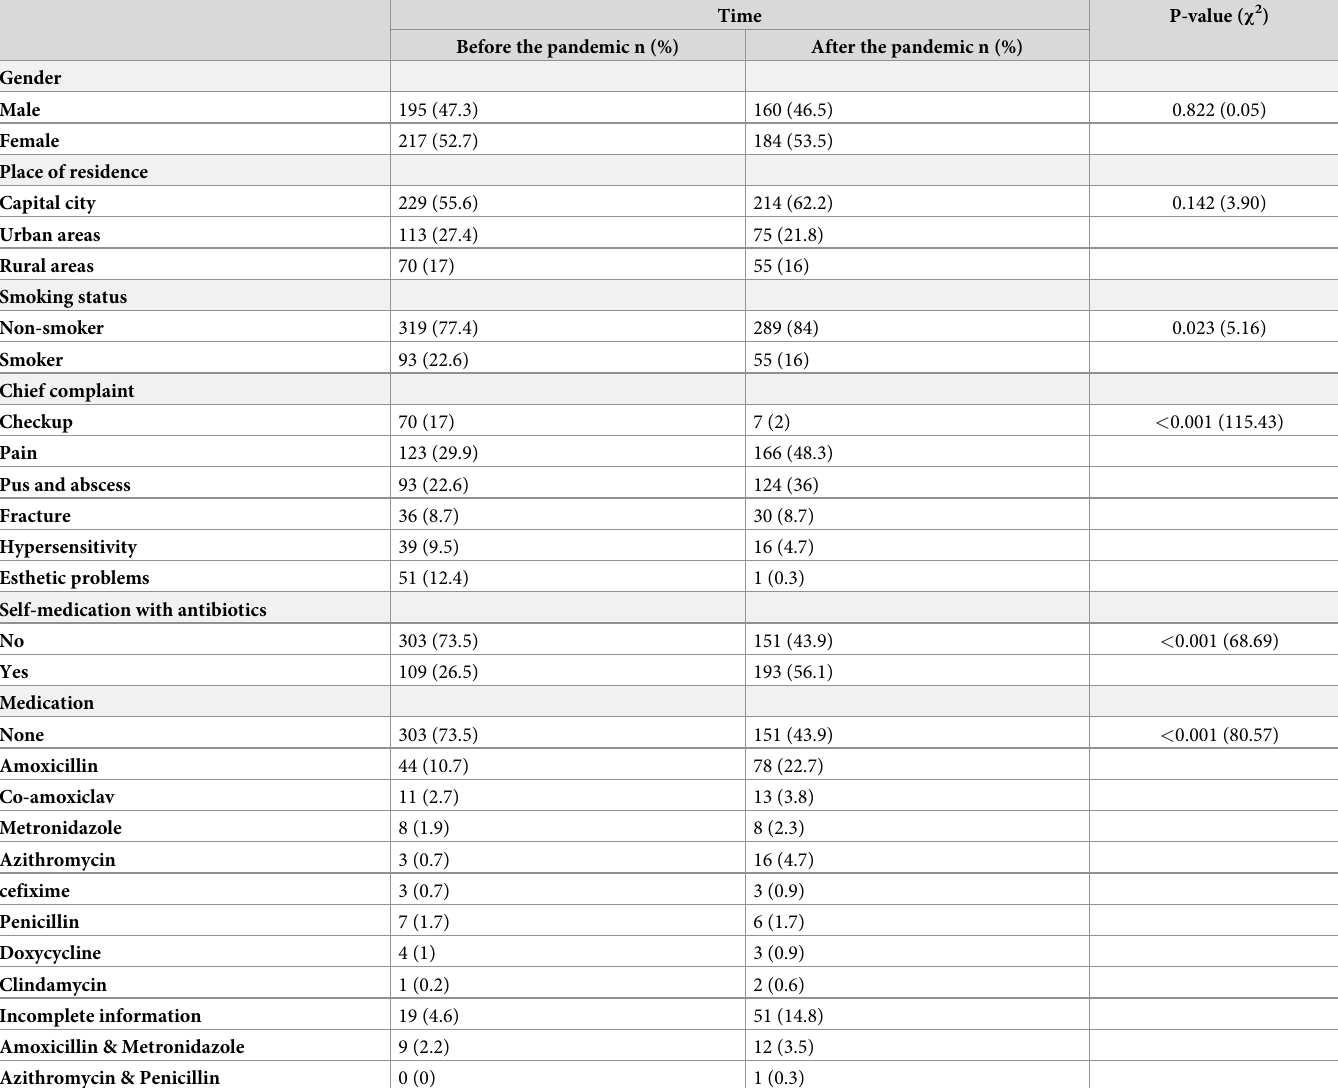
Table 1. Comparisons of the studied variables before and after the COVID-19 pandemic emergence among a group of dental patients (n = 756) in